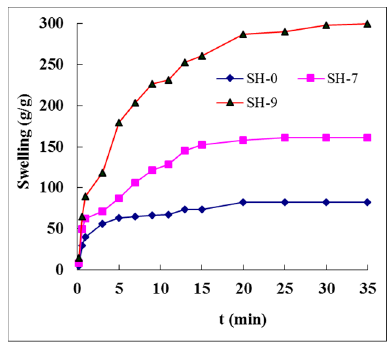
Figure 5. Swelling kinetics curves of different hydrogels.